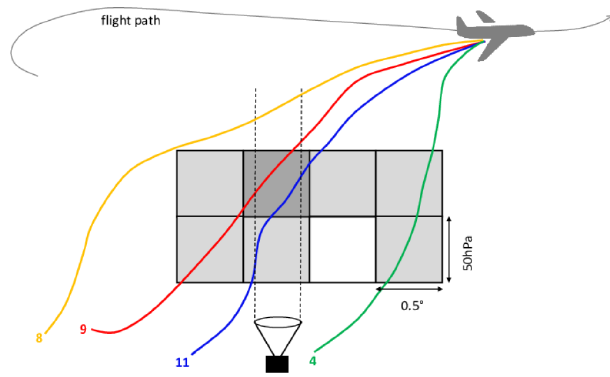
Figure 1. Schematic of the matching method: backward trajectories from the aircraft calculated in different EDA members (coloured trajectories), grid boxes with contributions from different numbers of EDA members (grey boxes; corresponding to match probabili- ties of 0–18% in this example, 18% because 2 out of 11 ensemble members indicate a match) and a remote sensing instrument observ- ing the match probability at that certain time step (black icon at the